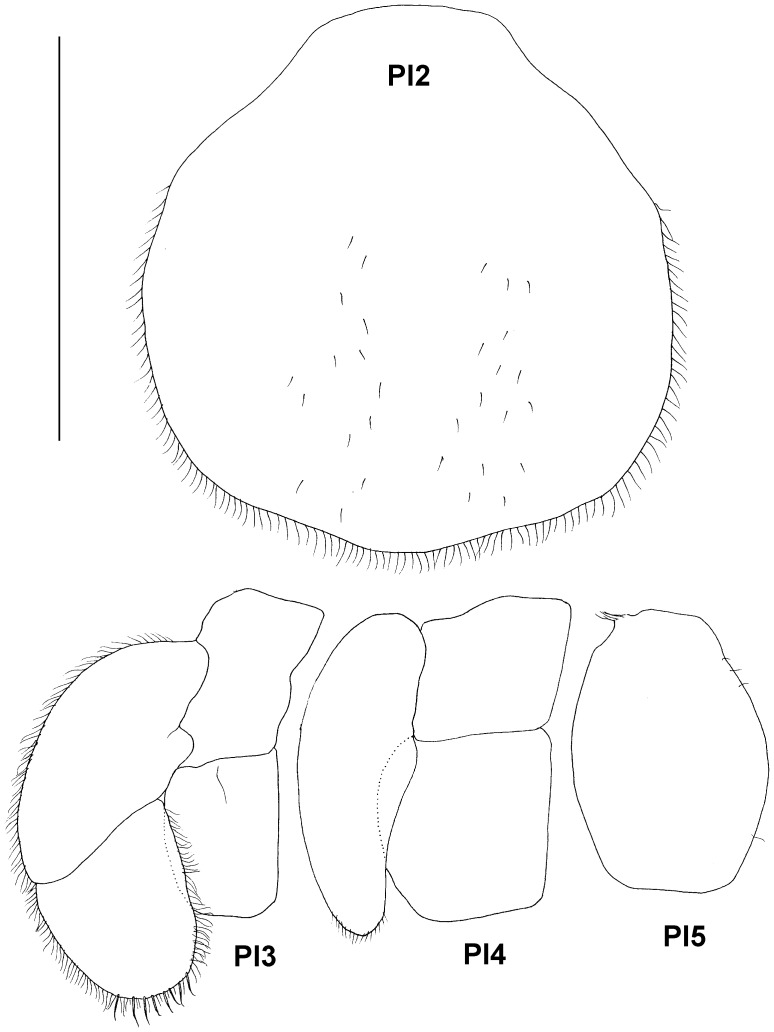
Paratype ZMH K-44089, female, pleopods 2–5, scale – 1 mm.